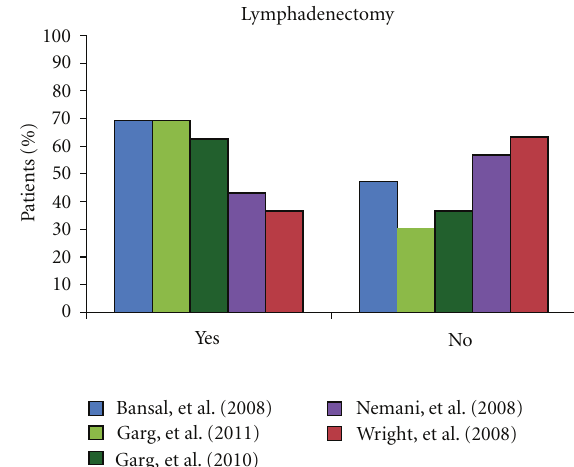
Figure 3: This column graph presents the percentage of patients who underwent lymphadenectomy among five of the six chosen index large case-based series of Bansal et al.[8], Garg et al. [10], Garg et al. [11], Nemani et al. [12], and Wright et al. [13]. Clayton Smith et al. [9] is not included as this data was not provided. This graph demonstrates that despite convincing evidence indicating the importance of lymphadenectomy as part of surgical treatment of uterine carcinosarcomas, a substantial proportion of patients do not undergo lymph-node